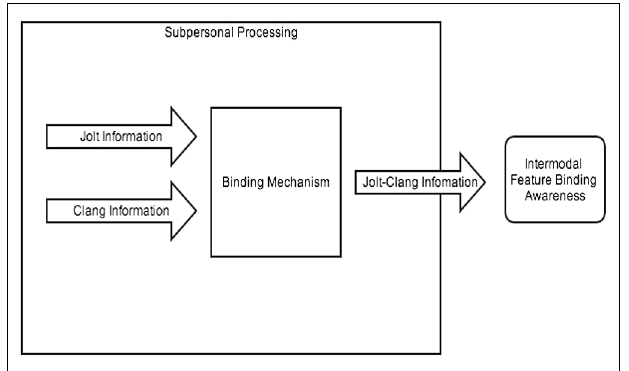
FIGURE 1 | Multimodal perception as an automatic binding process.